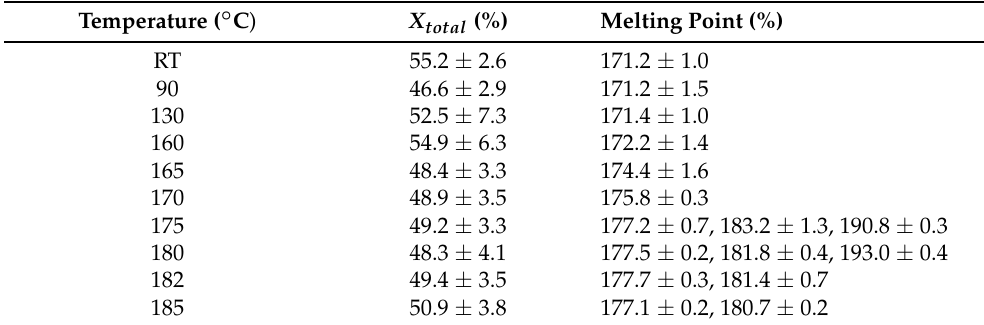
Table 1. Calculated crystallinity X and observed melting points [n RT = 10, n 90 to 185°C = 4].